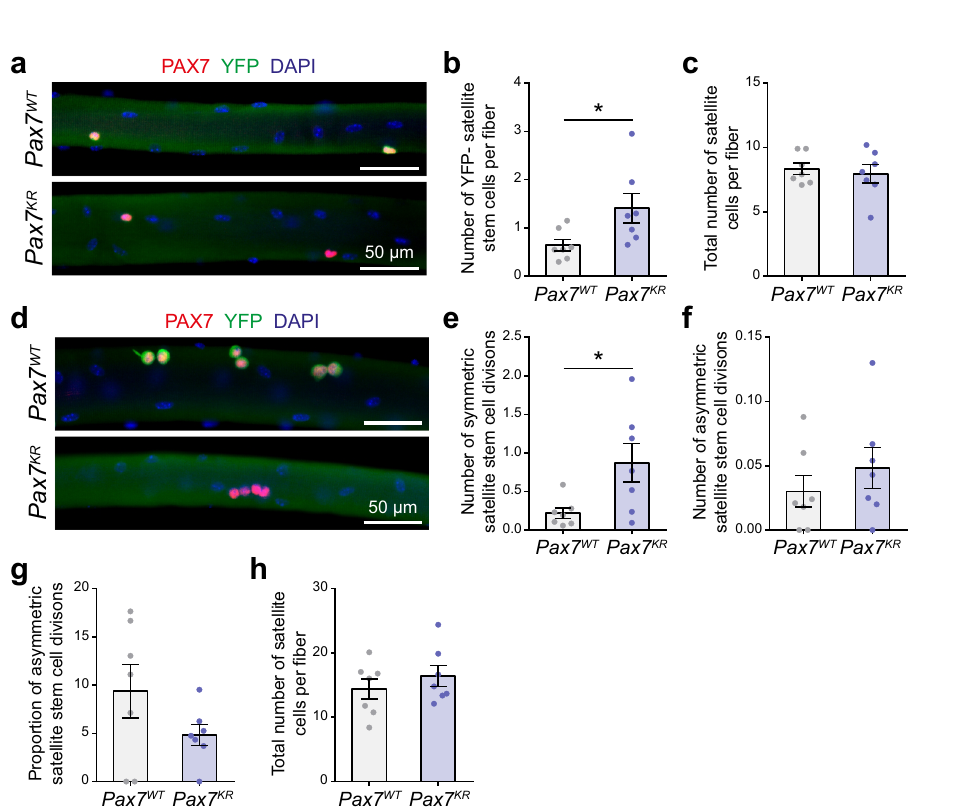
Fig. 7 PAX7 acetylation regulates asymmetric stem cell division. a Representative immunostaining of satellite cells on myo fi bers from Pax7 WT and Pax7 KR mice, immediately after isolation (0h). Myo fi bers were immunostained with YFP (green) and PAX7 (red), and nuclei were counterstained with DAPI (blue). Scale bar represents 50 μ m. Images are representative of ≥ 75% of the myo fi bers examined ( n = 7 mice per genotype). b Absolute numbers of YFP − satellite cells from Pax7 WT :Myf5-Cre:R26R-EYFP and Pax7 KR :Myf5-Cre:R26R-EYFP mice immediately after isolation. Data are presented as mean values±SEM ( n = 7 mice per genotype) (Two-tailed unpaired t test: * p = 0.0368). c Total number of satellite cells on myo fi bers from Pax7 WT :Myf5-Cre:R26R-EYFP and Pax7 KR :Myf5-Cre: R26R-EYFP mice immediately after isolation. Data are presented as mean values±SEM ( n = 7 mice per genotype). d Representative immunostaining of satellite cells on myo fi bers from Pax7 WT and Pax7 KR mice, after 42h of culture. Myo fi bers were immunostained with YFP (green) and PAX7 (red), and nuclei were counterstained with DAPI (blue). Scale bar represents 50 μ m. Images are representative of ≥ 75% of the myo fi bers examined ( n = 7 mice per genotype). e , f Absolute numbers per fi ber of ( e ) symmetric (YFP − /YFP − ) and ( f ) asymmetric (YFP + /YFP − ) satellite cell doublets from Pax7 WT :Myf5-Cre:R26R-EYFP and Pax7 KR :Myf5-Cre:R26R-EYFP mice at 42h post-isolation. Data are presented as mean values±SEM ( n = 7 mice per genotype) (Two-tailed unpaired t test: * p = 0.0276). g Proportion of asymmetric stem cell divisions after 42h of culture. Data are presented as mean values±SEM ( n = 7 mice per genotype). h Total satellite cell numbers after 42h of culture. Data are presented as mean values±SEM ( n = 7 mice per